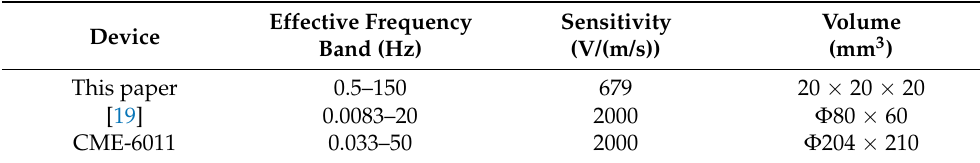
Table 1. The effective frequency bands and sensitivities of co-oscillating vector hydrophones based on different working principles.